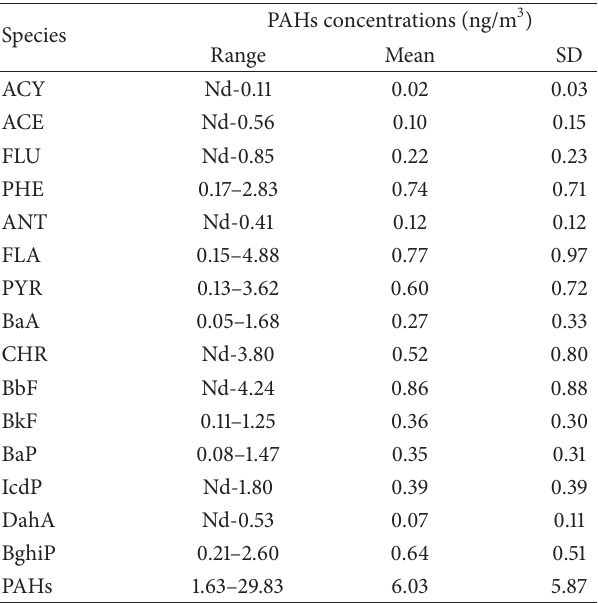
Table 1: The abbreviations for PAH compounds and their detection limits.